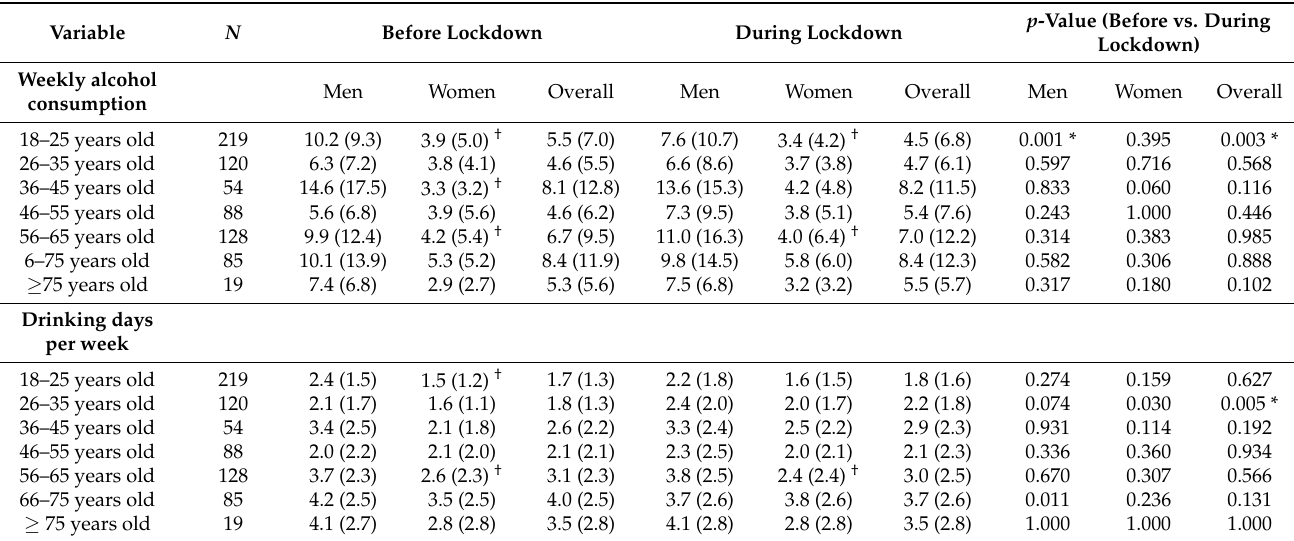
consumption on perceived immune fitness and experiencing COVID-19 symptoms was conducted using data only from the younger age groups (18- to 35-year-old participants). Table 3. Alcohol consumption before and during lockdown according to age.